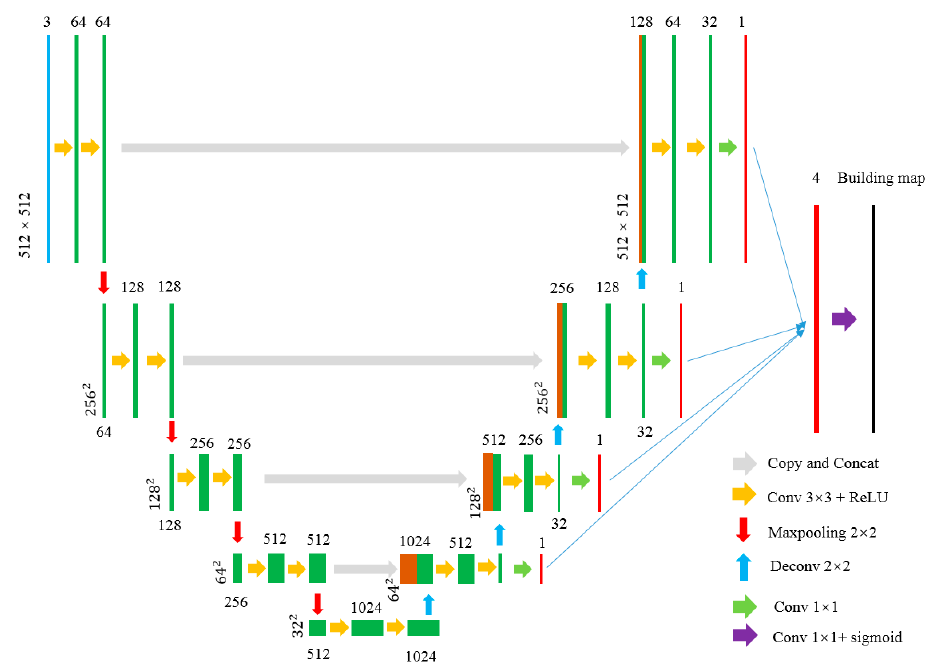
Figure 3. The MS-FCN framework for semantic segmentation.